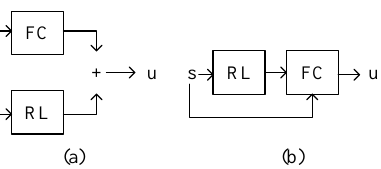
Figure 1. Combination of FC and RL: ( a ) the parallel model. ( b ) The serial